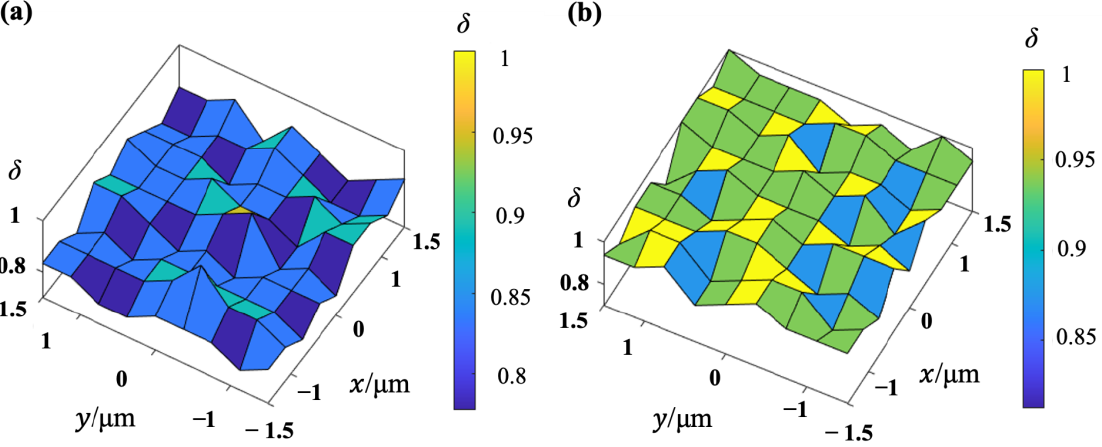
Figure 10. Distribution of the modulation efficiency at different input laser powers: ( a ) 3 mW and ( b ) 4 mW.